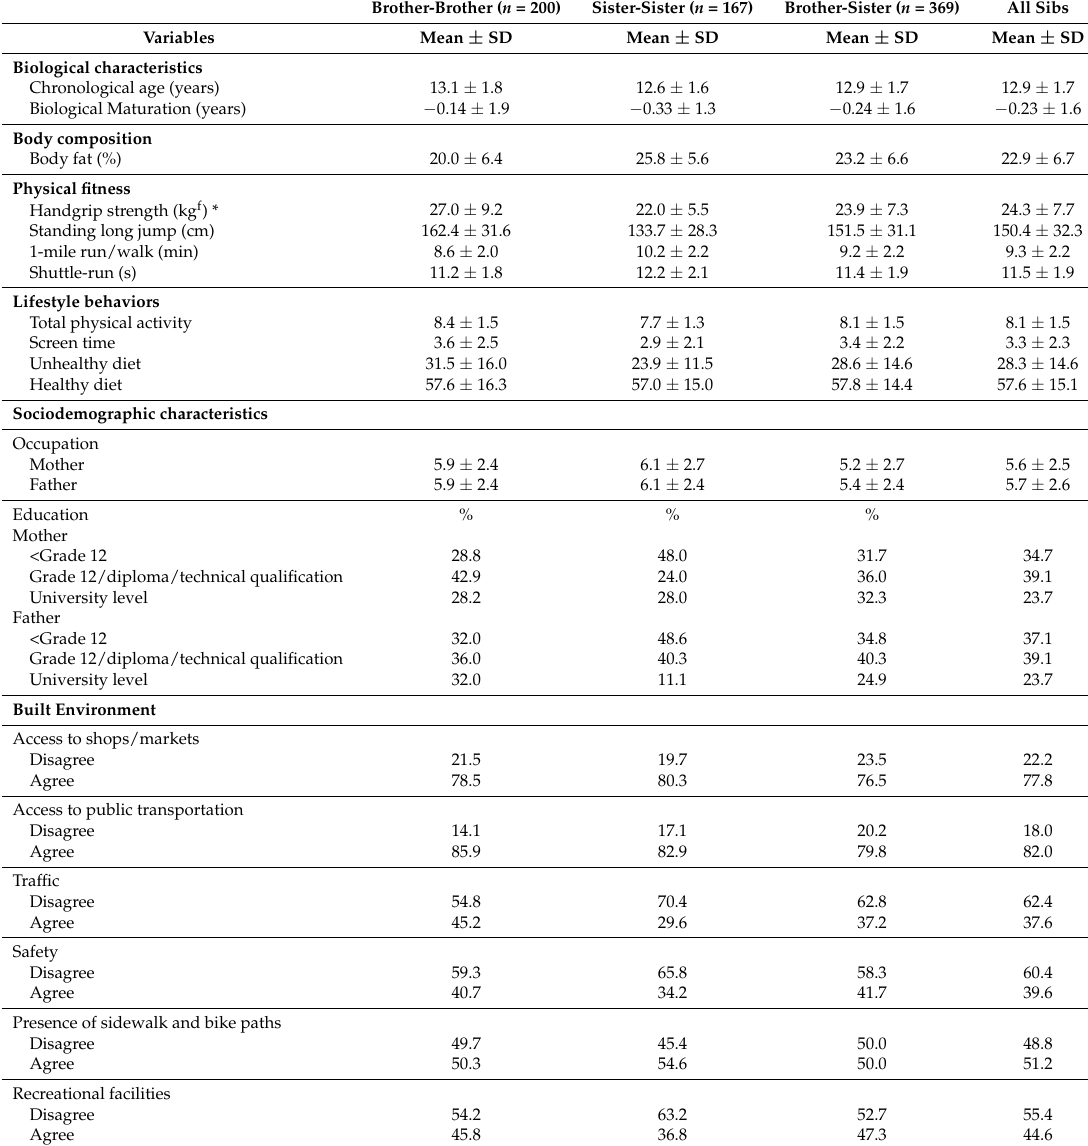
Table 1. Sample descriptive characteristics (means, standard deviations (SD), and frequencies (%)) for sibling pairs.